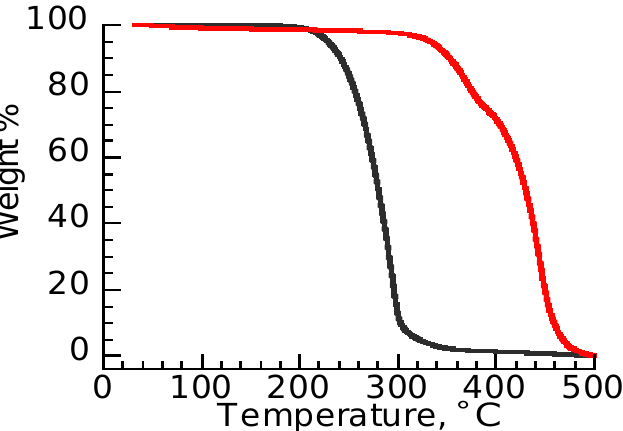
Figure 3. TGA curves of PAO (black line) and DNIG-1 (red line).